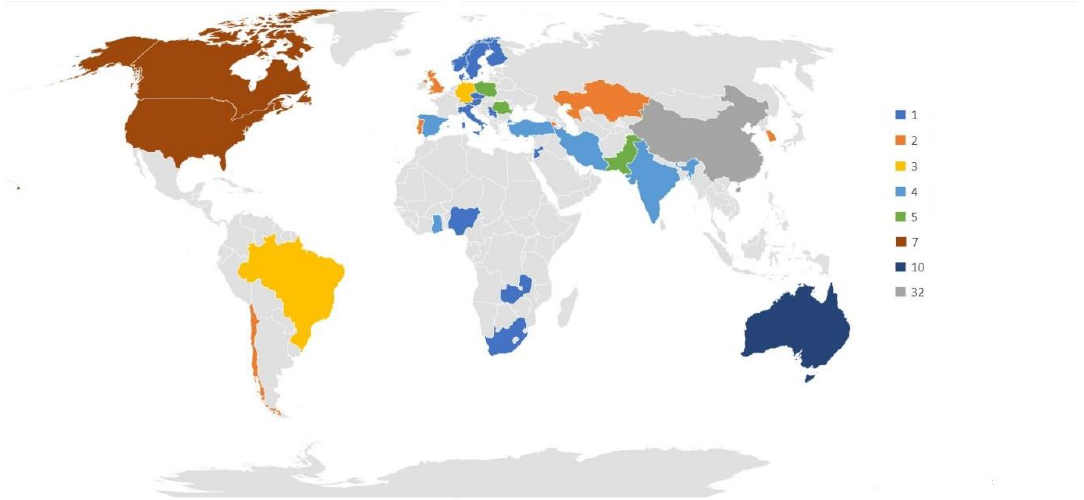
Figure 4. Number of papers by location where the study took place.